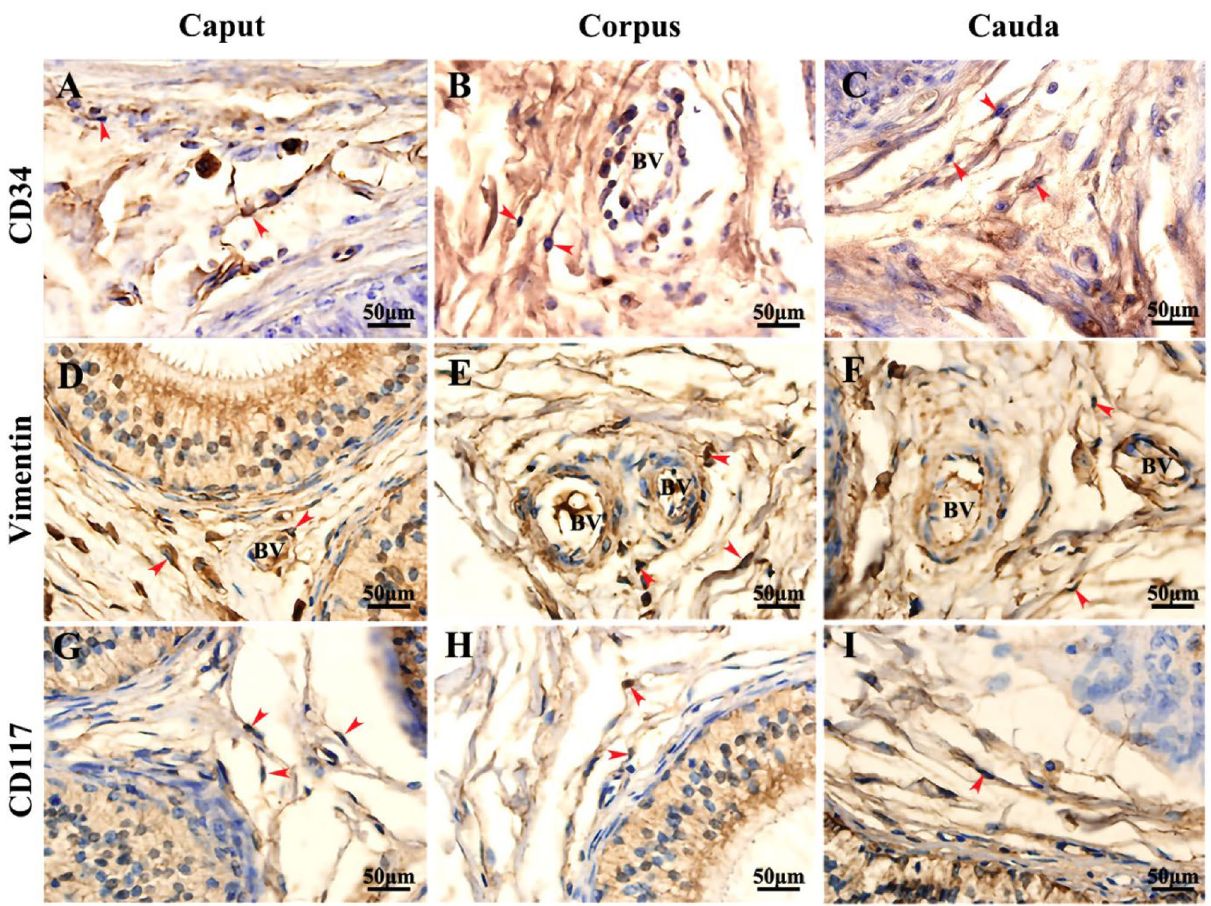
immunohistochemical staining results of Vimentin in caput, corpus and cauda of epididymis. ( G – I ) The immunohistochemical staining results of CD117 in caput, corpus and cauda of epididymis. There were